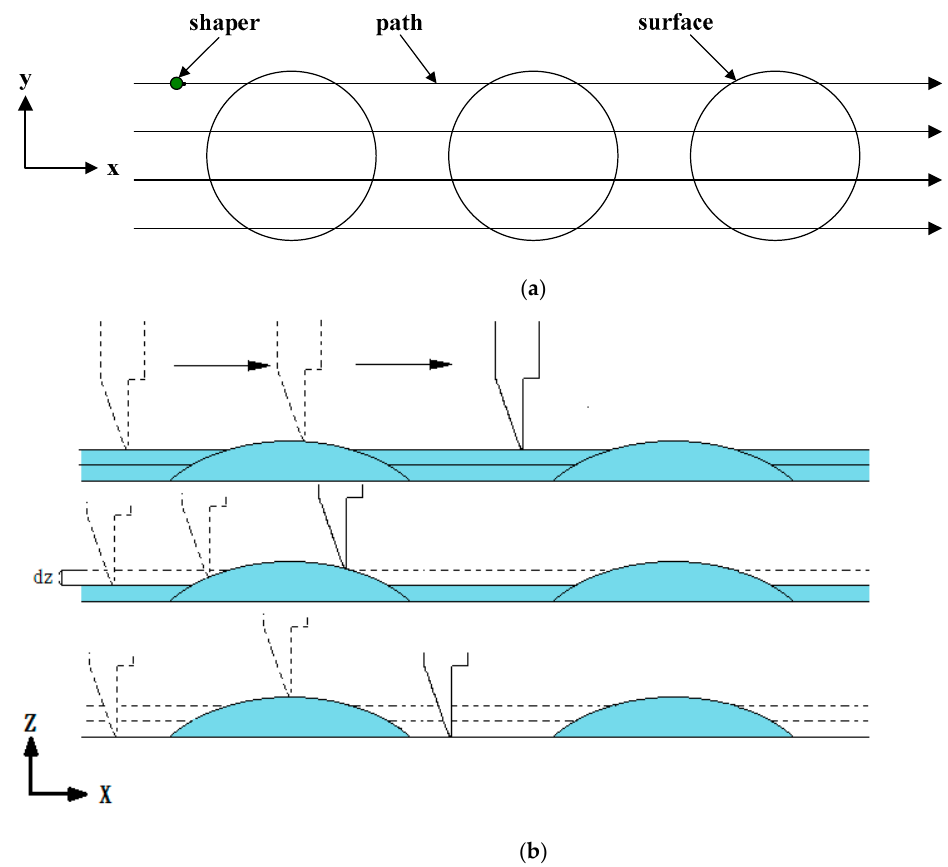
Figure 5. Cutting path of the microshaper: ( a ) x-y plane and ( b ) x-z plane. The x-direction is the feed direction of the microshaper. As the shaper finishing machining the path in feed direction, it will move to next path in y direction and continue to machine.